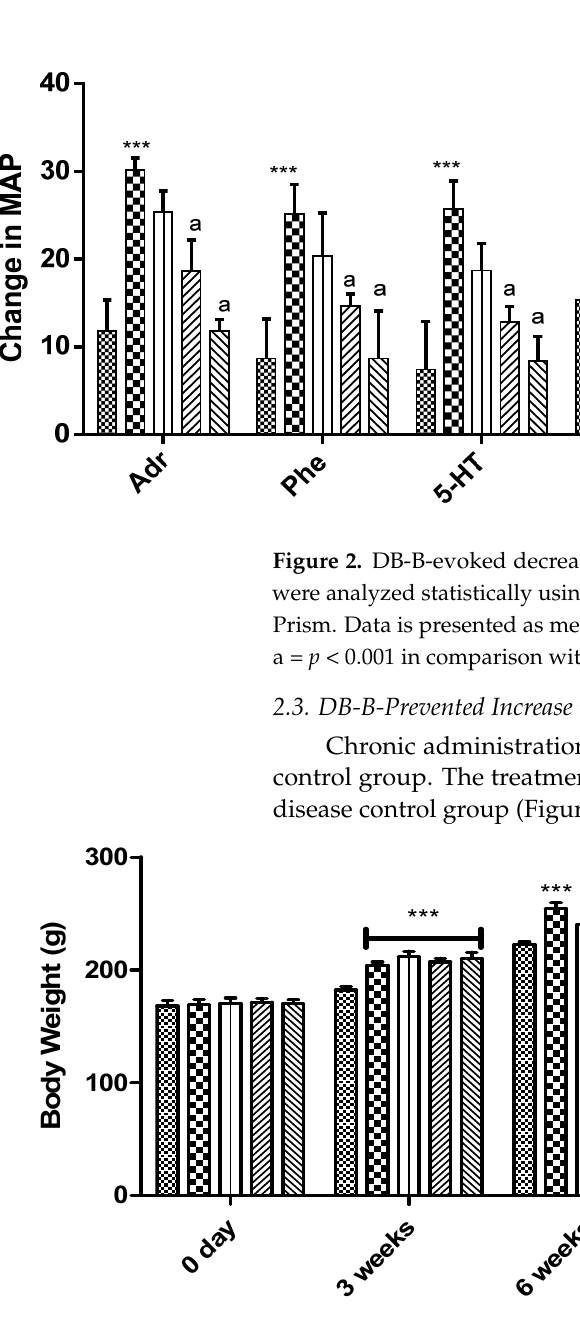
Figure 3. Butanolic fraction of D. brunonianum caused a decrease in the body weight of fructose hypertensive anesthetized rats. Data was analyzed statistically using two-way ANOVA followed by the Bonferrani test. Results are presented as mean ± SEM (n = 5) where *** = p < 0.001 compared with the control, while a = p < 0.001 and c = p < 0.05 compared with fructose (10%).